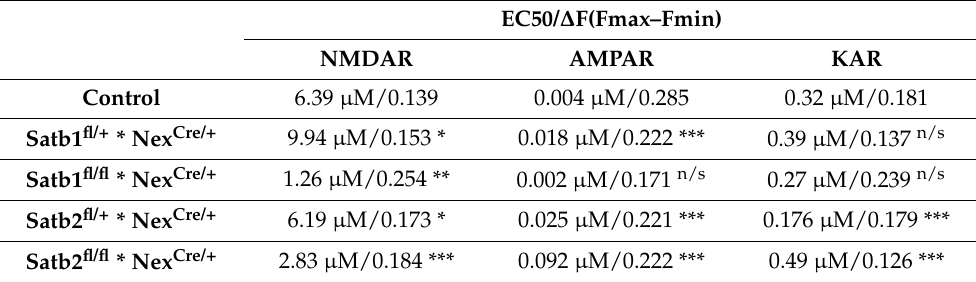
Table 2. The effect of Satb1 and Satb2 deletion on agonist-induced Ca 2+ -responses of cortical